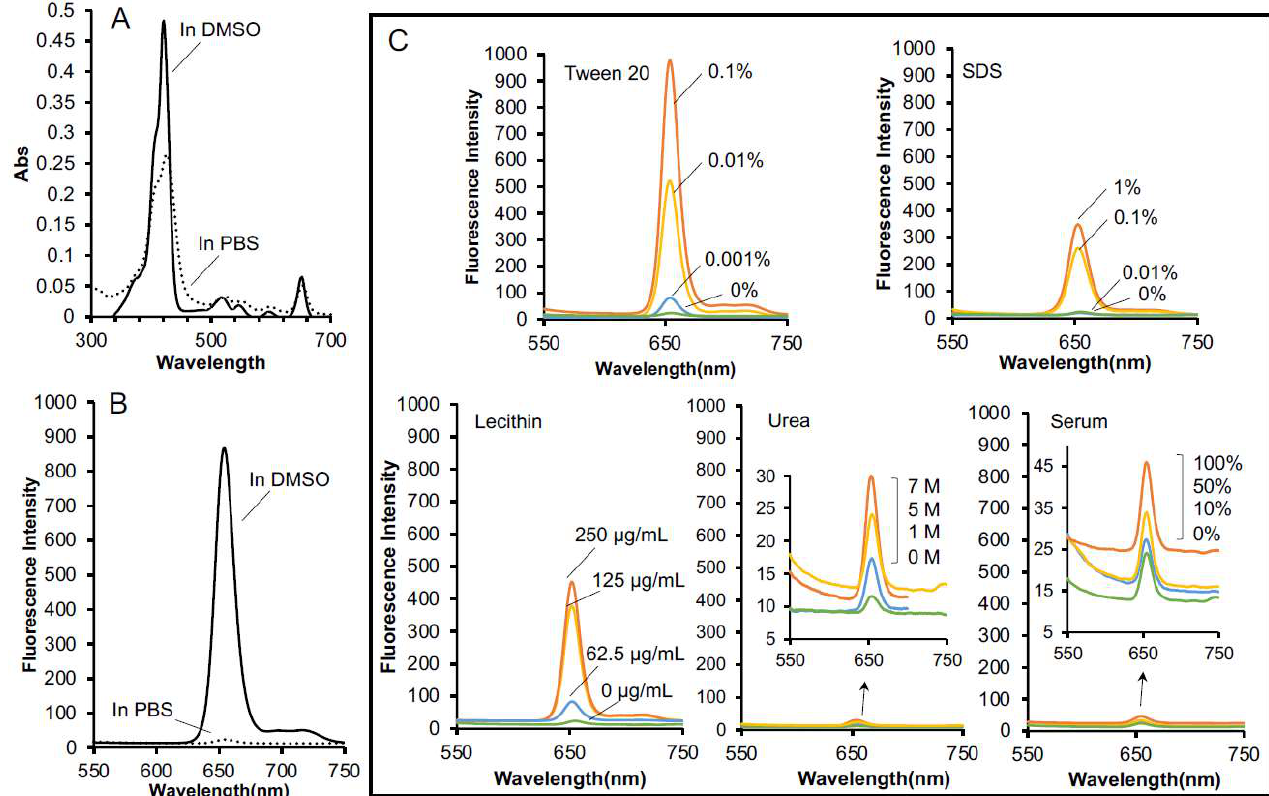
Figure 1. ( A ) Diagrammatic illustration of the micelle structure of SMA@mTHPC and ( B ) the hydrodynamic size of SMA@mTHPC in aqueous solution determined by dynamic light scatter (DLS).